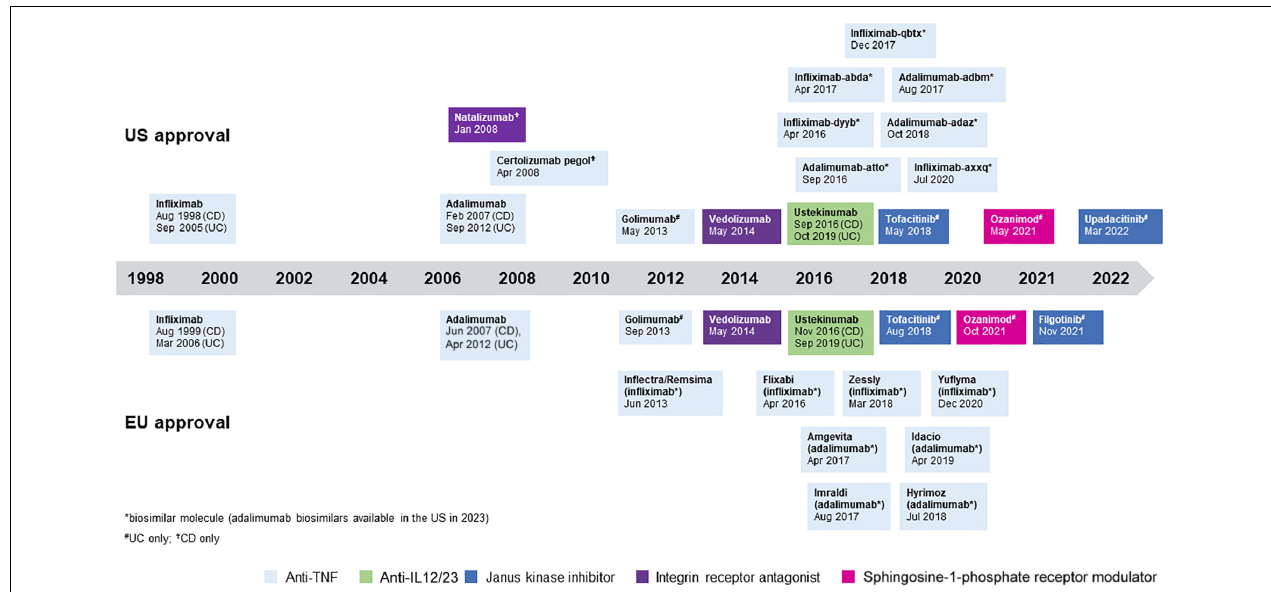
FIGURE 1 | Approved treatments for inflammatory bowel disease (IBD). All treatments are approved for Crohn’s disease (CD) and ulcerative colitis (UC) unless otherwise